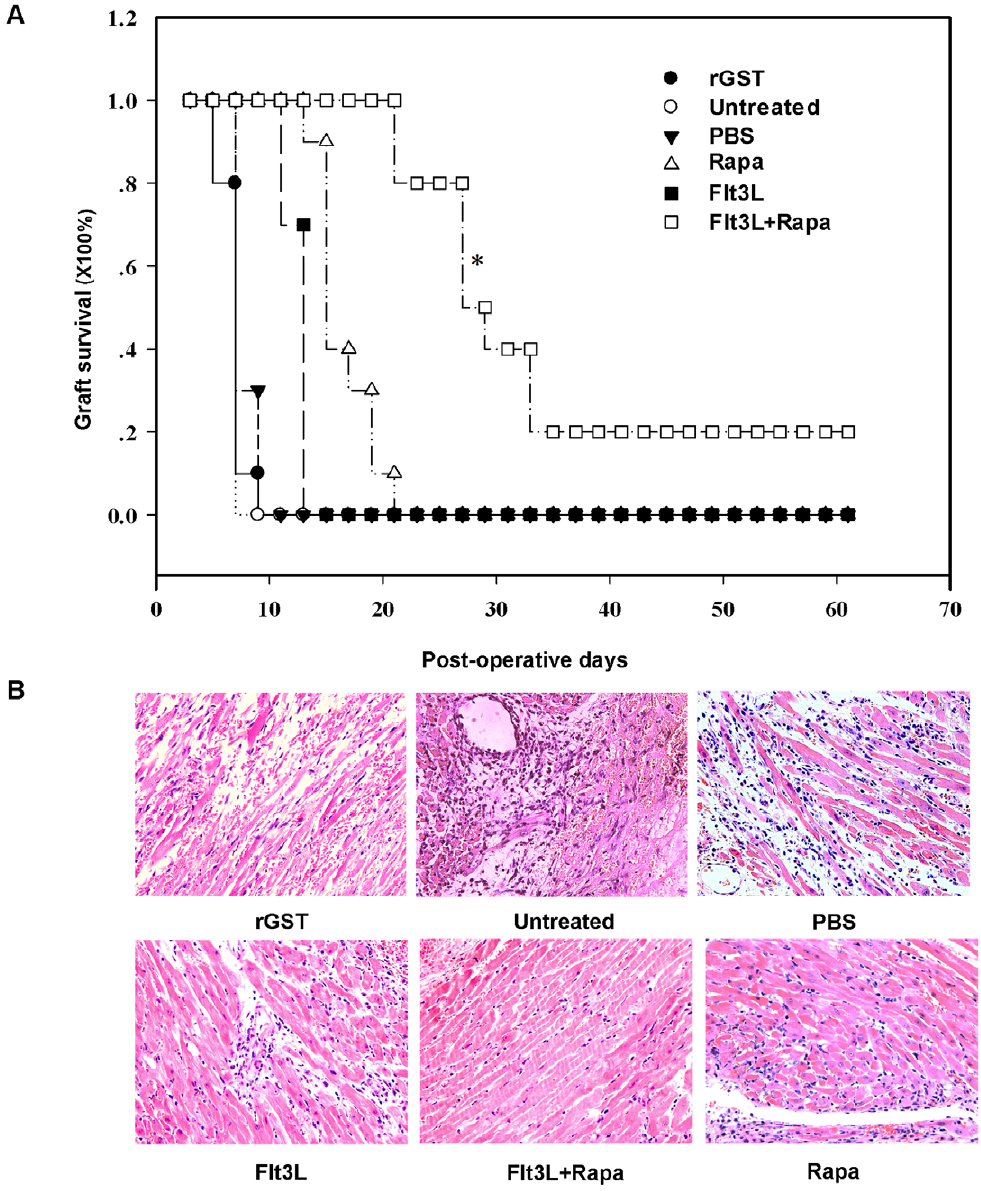
Figure 1. Flt3L combined with low-dose of Rapa prolongs cardiac allograft survival and attenuates infiltrates in the graft. (A) Heart allograft survival. The cardiac allograft survival time in recipients treated with Flt3L (10 m g/day, i.v.) and low-dose of Rapa (2 mg/kg/day; p.o, POD0-15) was significant longer than those of the untreated and monotherapy groups (n=10) (* P , 0.05, combination therapy group vs. other groups). (B) Histology of cardiac allografts. Grafts were harvested at the time of rejection or at study endpoint (POD 100) and evaluated by H&E staining of paraffin sections (original magnification, 6 200). The results are representative of three independently performed experiments.